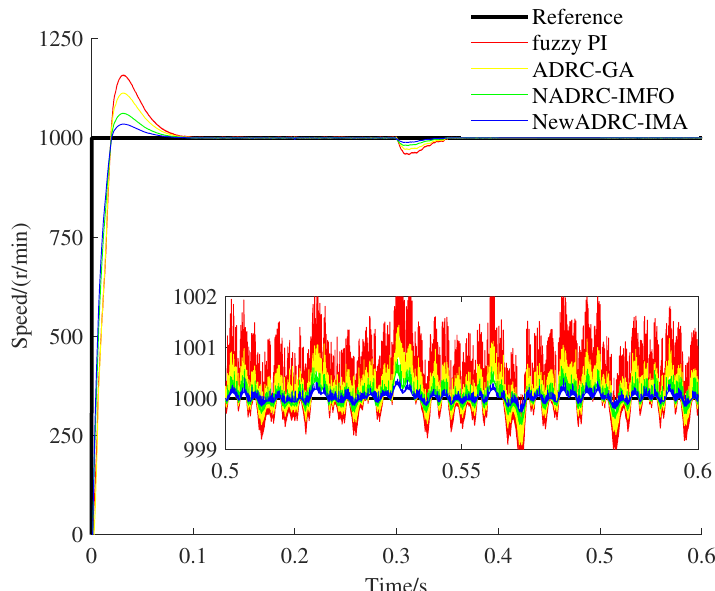
Figure 8. The speed curves under the first PMSM velocity control practical case.